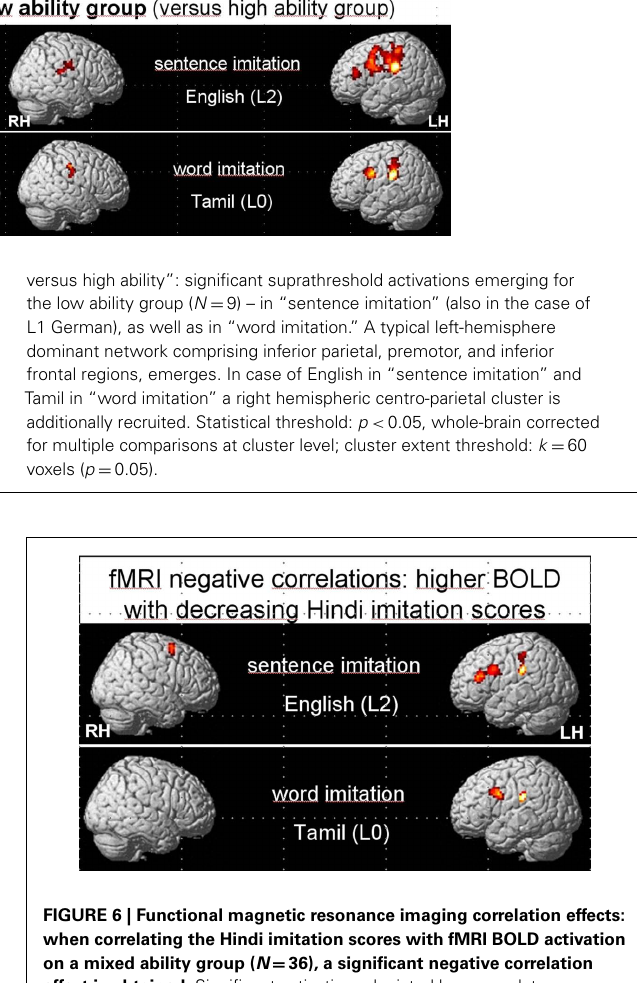
FIGURE 6 | Functional magnetic resonance imaging correlation effects: when correlating the Hindi imitation scores with fMRI BOLD activation on a mixed ability group ( N = 36), a significant negative correlation effect is obtained. Significant activations depicted here correlate negatively with the Hindi imitation score (decreasing imitation scores yield higher BOLD activation).The activated areas are largely overlapping with the activated areas found in the previous analyses ( Figure 5 ).They are obtained in both tasks, “sentence imitation” (example upper panel) and “word imitation” (example lower panel). Statistical threshold: p < 0.05, whole-brain corrected for multiple comparisons at cluster level; cluster extent threshold: k = 64 voxels ( p =